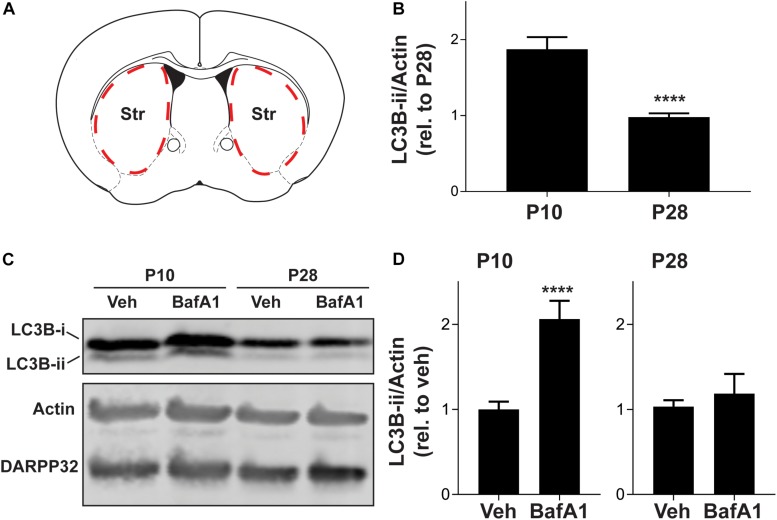
Striatal autophagic flux decreases from P10 to P28. (A) Schematic of coronal brain section showing dissection boundaries for ex vivo experiments. (B) Quantification of LC3B-ii relative to actin for every vehicle-only slice showed in Figures 4, 5. Unpaired, two-tailed t-test, t52 = 5.824, ****p < 0.0001. (C) Representative Western blot images of actin, DARPP32 and LC3B in slices obtained from P10 or P28 mice, incubated with BafA1 (100 nM, 3 h) or vehicle (Veh; DMSO, 0.1%). (D) LC3B-ii relative to actin, normalized to vehicle condition at each age. P10: unpaired, two-tailed t-test, t25 = 5.113, ****p < 0.0001; P28: unpaired, two-tailed t-test, t10 = 0.6228, p = 0.5473. P10: Veh: n = 16 slices, BafA1 n = 11 slices from 4 to 6 mice. P28: Veh: n = 6 slices, BafA1 n = 6 slices from three mice.